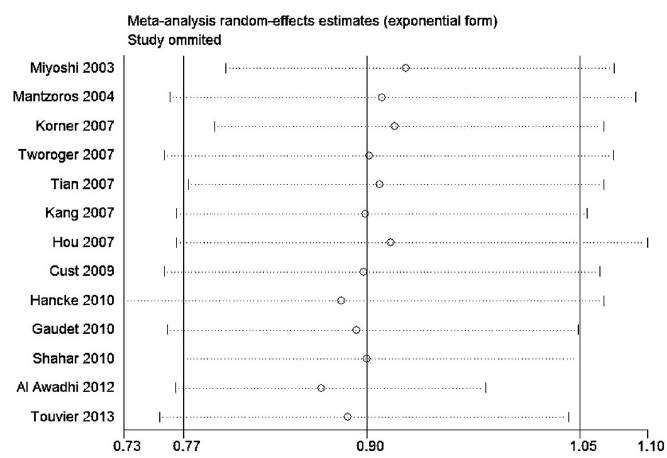
Figure 5. The influence of individual study on the pooled estimate